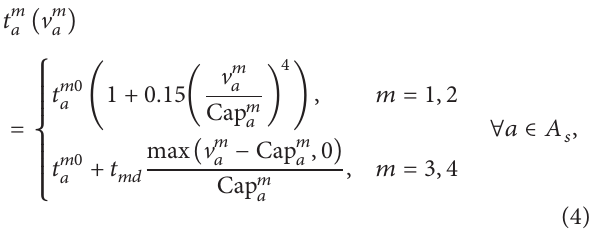
Algorithm 2 (Algorithm for the model of logistics user’s